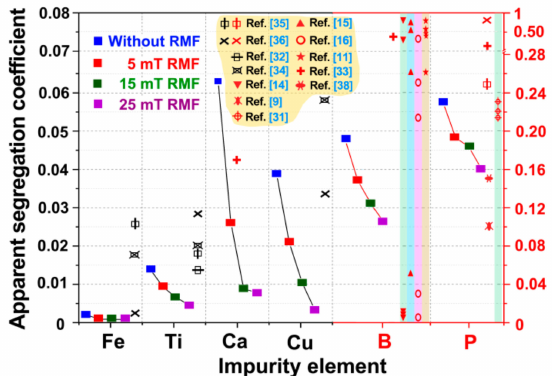
Figure 8. The apparent segregation coe ffi cients of impurities in this experiment and comparison with other experiments